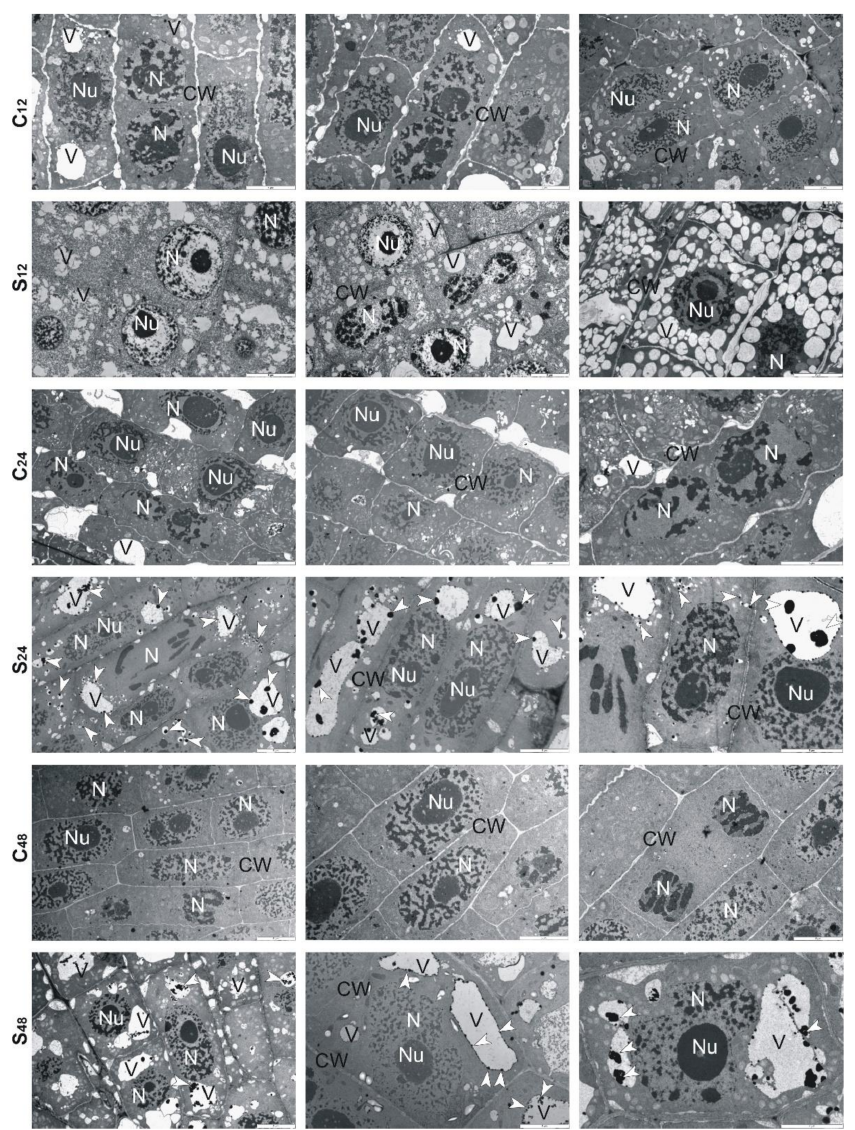
Figure 6. Representative results of the ultrathin sections taken from the roots of tolerant rye cv. “Da´nkowskie Złote” at 12, 24 and 48 h after treatment with Al 3+ (0.59 mM) (S) and in untreated plants (C). Caption: arrowheads: electron-dense precipitate, CW: cell wall, N: nucleus, Nu: nucleolus, V: vacuole. Bar= 5 µ